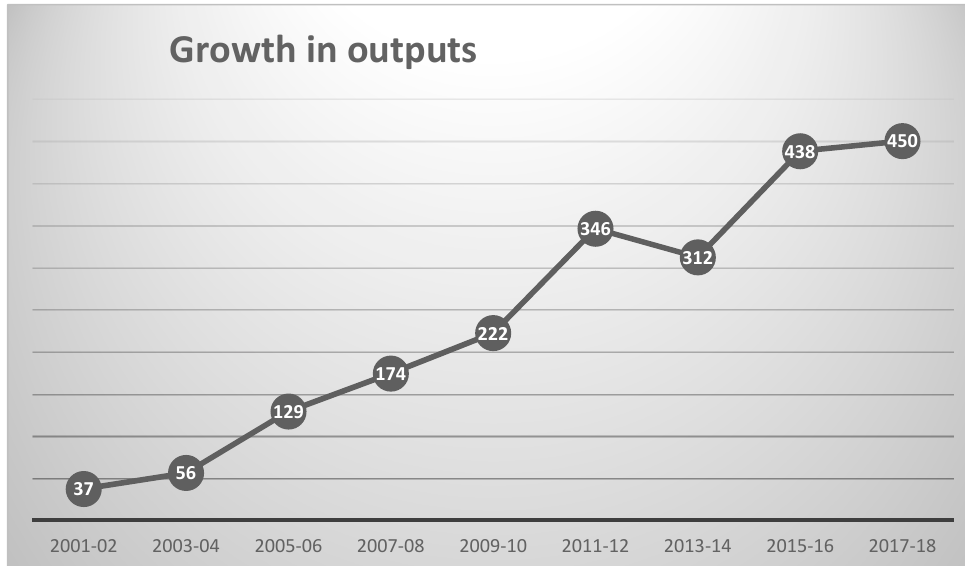
Figure 1. Growth in annual chemoinformatics outputs since 2001.